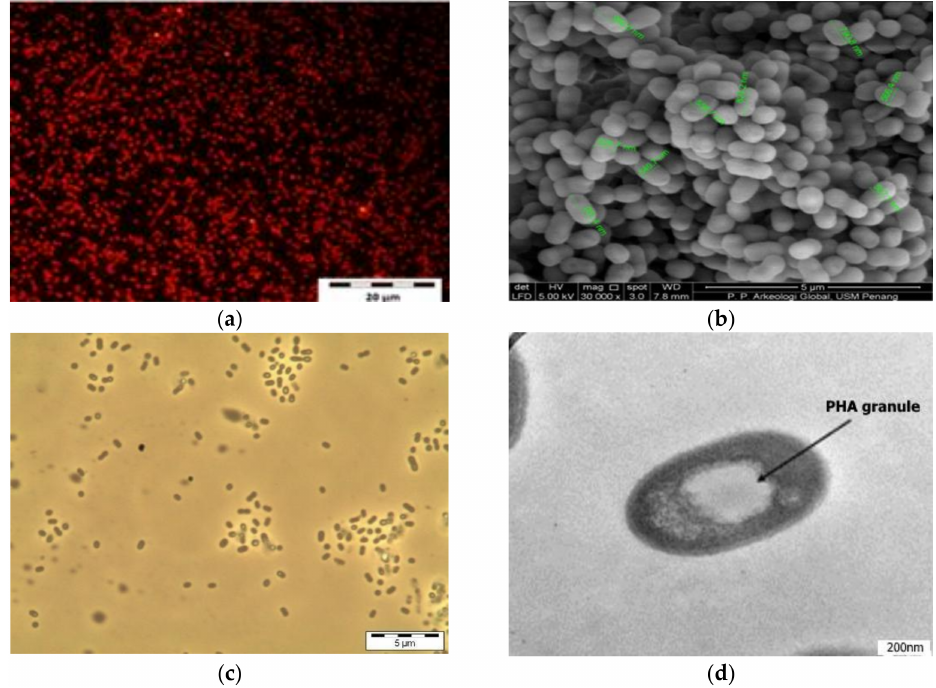
Figure 1. Nile red fluorescence micrograph ( a ), Scanning electron micrograph ( b ), Phase contrast micrograph ( c ), and Transmission electron micrograph ( d ) of a selected isolate SPD2. The black arrow indicates PHA granule within the cell.